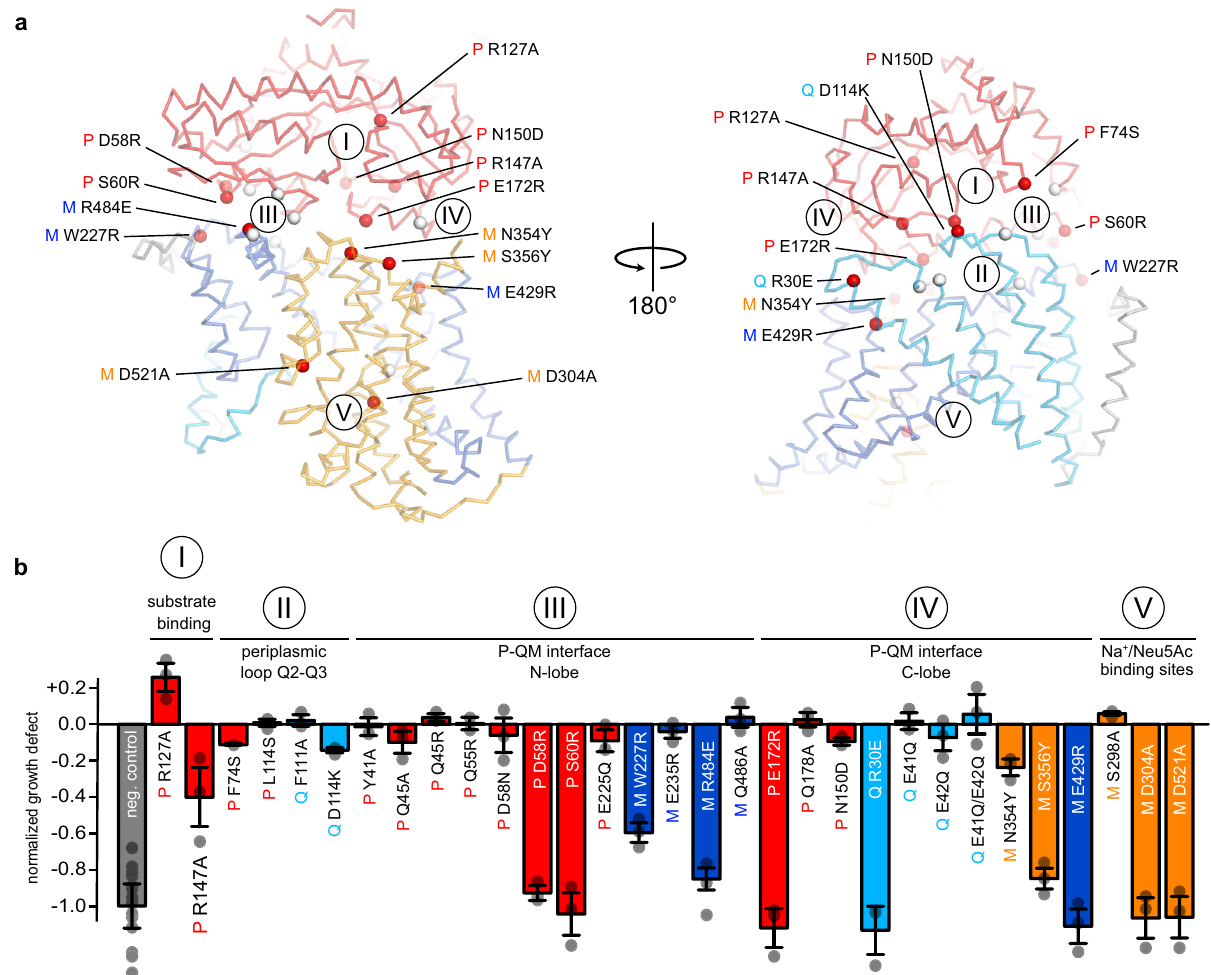
Fig. 5 Validation of the tripartite P-QM complex. a Structural context of the mutations in the AlphaFold model of the tripartite complex. The P-domain is colored red and the QM-domains are color-coded as in Fig. 1. Red spheres indicate mutants that showed a signi fi cant effect in the growth assay and are labelled. White spheres represent the remaining mutants. b Growth defect after 17 h (compared to a wildtype culture and normalized to the negative control) of TRAP transporter mutants in a sialic acid uptake assay. The positions of the mutants with respect to the tripartite complex are indicated by labels and the color code. Data are presented as mean values ± SD of n ≥ 3 independent experiments. Source data are provided as a Source Data fi